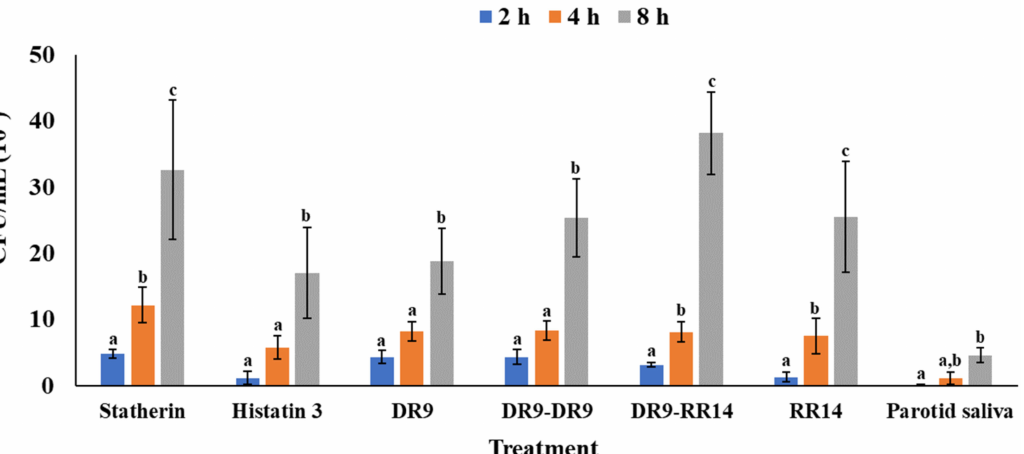
Figure 2. Colony-forming units (CFU/disc*10 5 ) of S. mutans adhered to hydroxyapatite (HAp) discs within treatment according to the adhesion time. Distinct lower-case letters show significant differ- ences among time points within each treatment (ANOVA and Bonferroni test, p < 0.05) (Mean ± SD; n = 6).